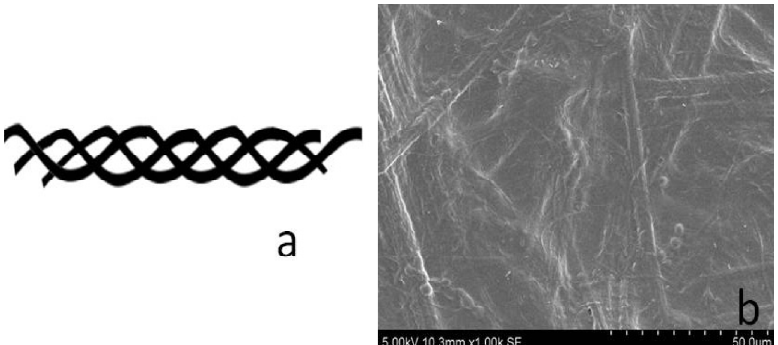
Fig. 1. (a) Schematic diagram of triple helical structure of collagen and (b) SEM image of isolated collagen from